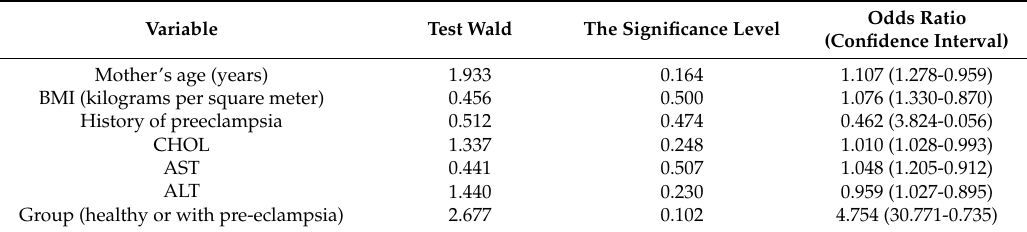
Table 7. Logistic regression findings with respect to the outcomes of non-alcoholic fatty liver.